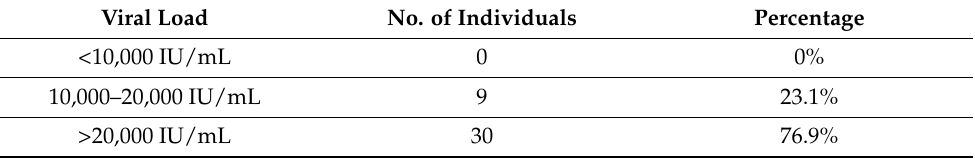
Table 4. In this table, viral load of the HBV-positive ( n = 39) individuals is shown, distributed in three